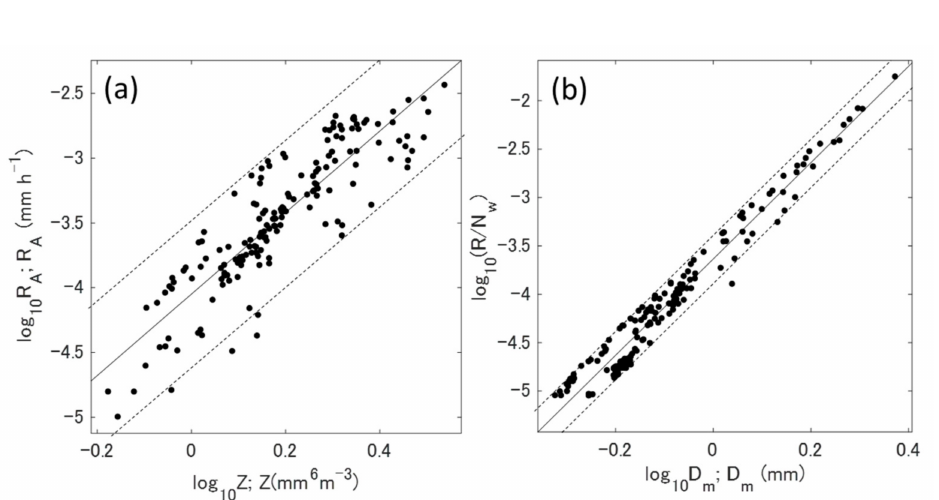
Figure 14. Quantitative ash fall estimation based on the relationships among integrated PSD param- eters including ( a ) R A – Z , ( b ) R A /N w – D m , where R A , N w , and D m were calculated using PSD data obtained by Parsivel 2